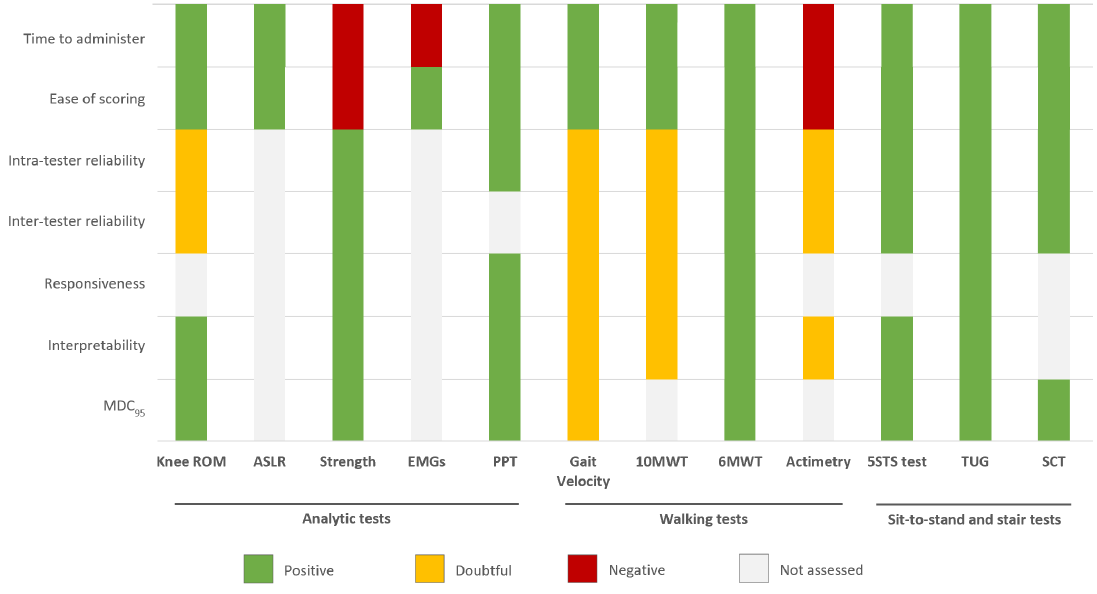
Figure 3. Summary of the quality assessment of the included physical tests. MDC 95 = minimal detectable change at the 95% confidence level; see Table 2 for additional abbreviations.